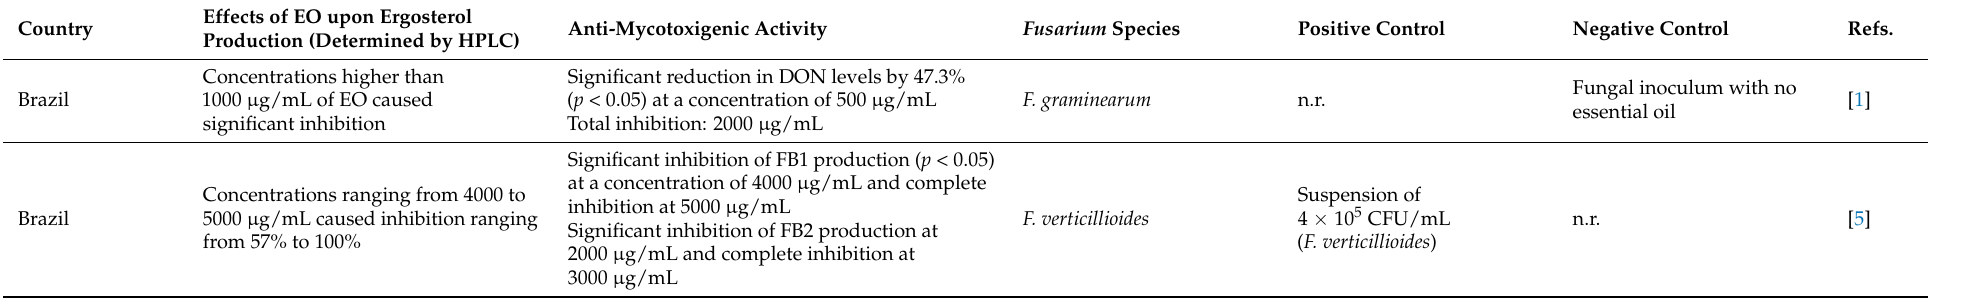
Table 2. Ergosterol quantification and anti-mycotoxigenic activity of several Z. officinale